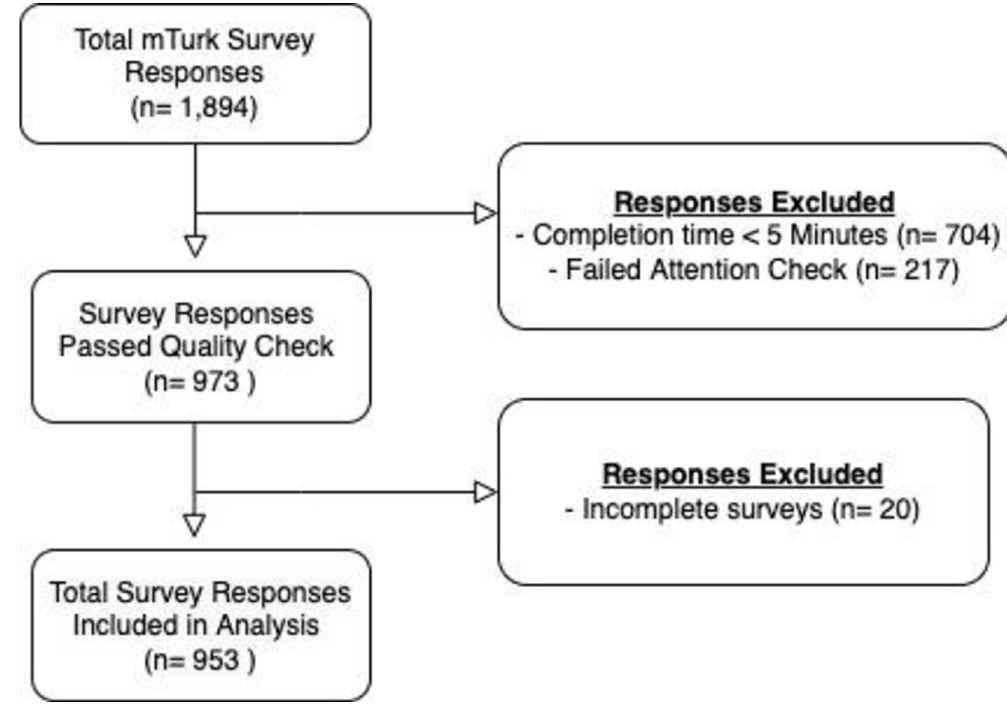
Fig 1. Participant